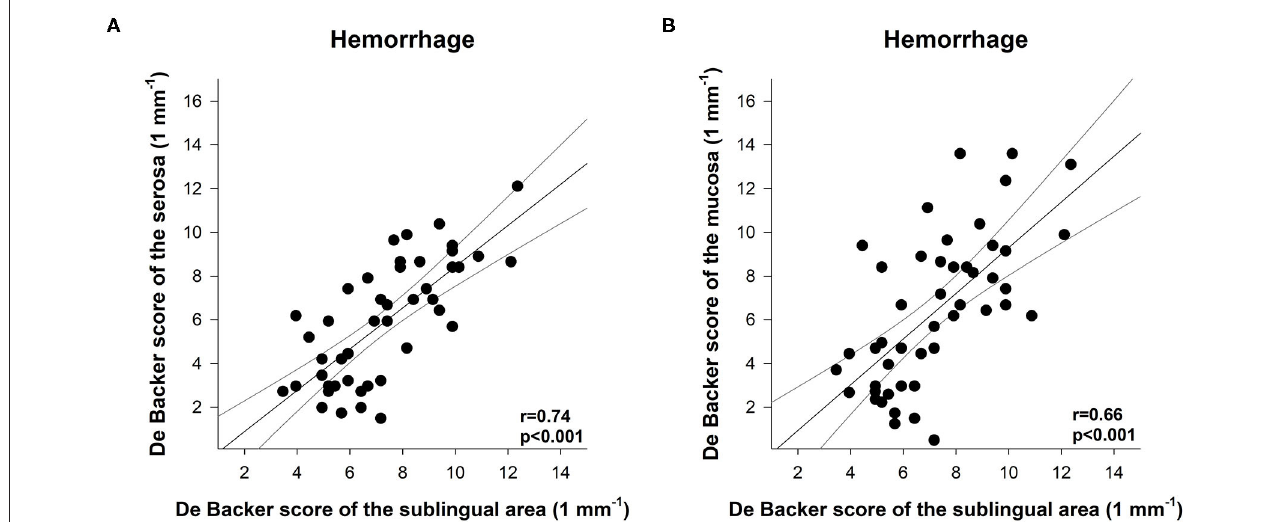
FIGURE 8 | Correlation between the De Backer score (1 mm − 1 ) for the serosa (A) or mucosa (B) and the De Backer score (1 mm − 1 ) for the sublingual area during the hemorrhage phase. The plot demonstrates the regression line (gray line) and corresponding (black scatters) r values as an indicator of the strength of the linear correlation and p significance